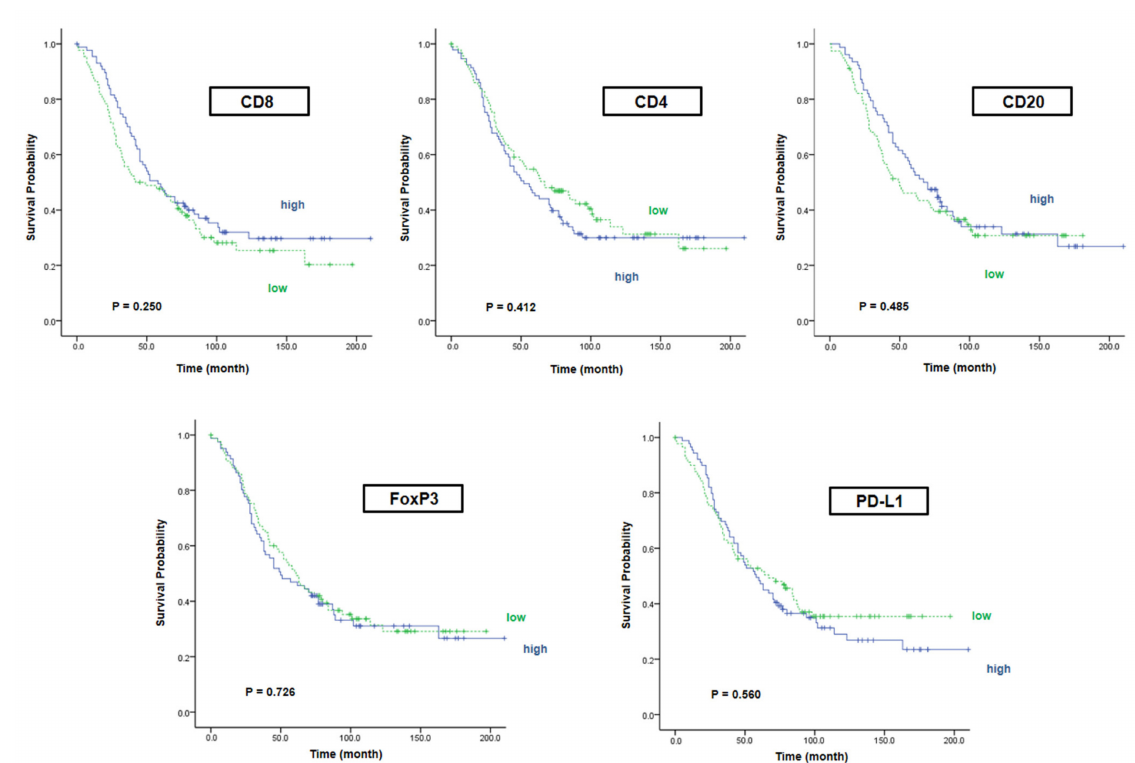
Figure 3. Overall survival according to each immune marker. We classified patients according to the degree of marker expression and analyzed the overall survival according to each marker. As a result, any single immune marker was not related to survival rate.